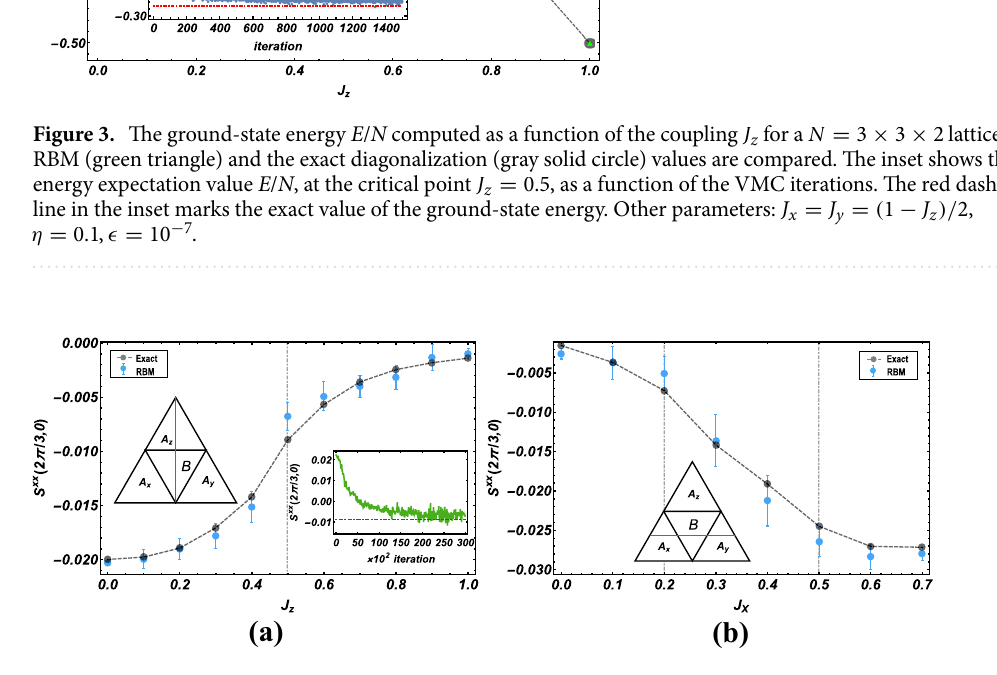
Figure 4. The spin-structure factor S xx ( 2 π/ 3, 0 ) (blue solid circle), compared with exact diagonalization results (gray solid circle), as a function of the coupling: ( a ) J z , other parameters are set as J x = J y = ( 1 − J z )/ 2 ; ( b ) J x , other parameters are set as J z = 0.3, J y = 0.7 − J x for a N = 3 × 3 × 2 lattice. The blue solid straight lines are plotted to indicate the error bars. Inset in ( a ): the convergence of the structure factor towards the exact value in the training process, at the critical point J z = 0.5 . The red dashed line in the inset marks the exact